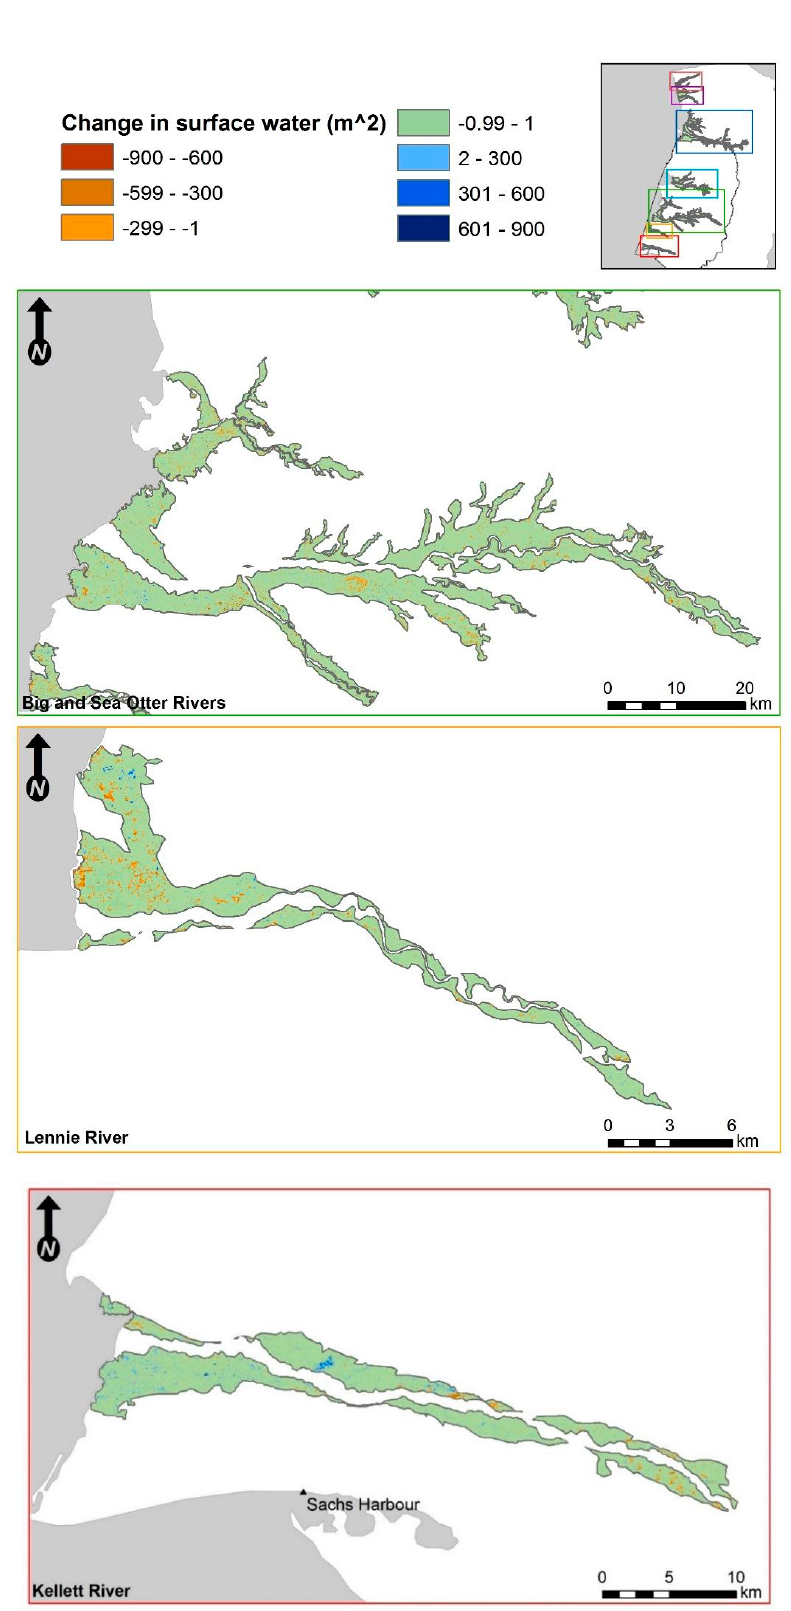
Figure A3. Sub-pixel water fraction trend surfaces of the Sea Otter, Big, Lennie, and Kellett river valleys of western Banks Island, between